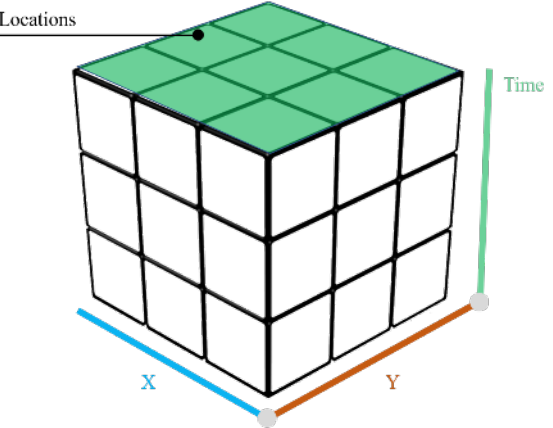
Figure 6. A space-time cube.